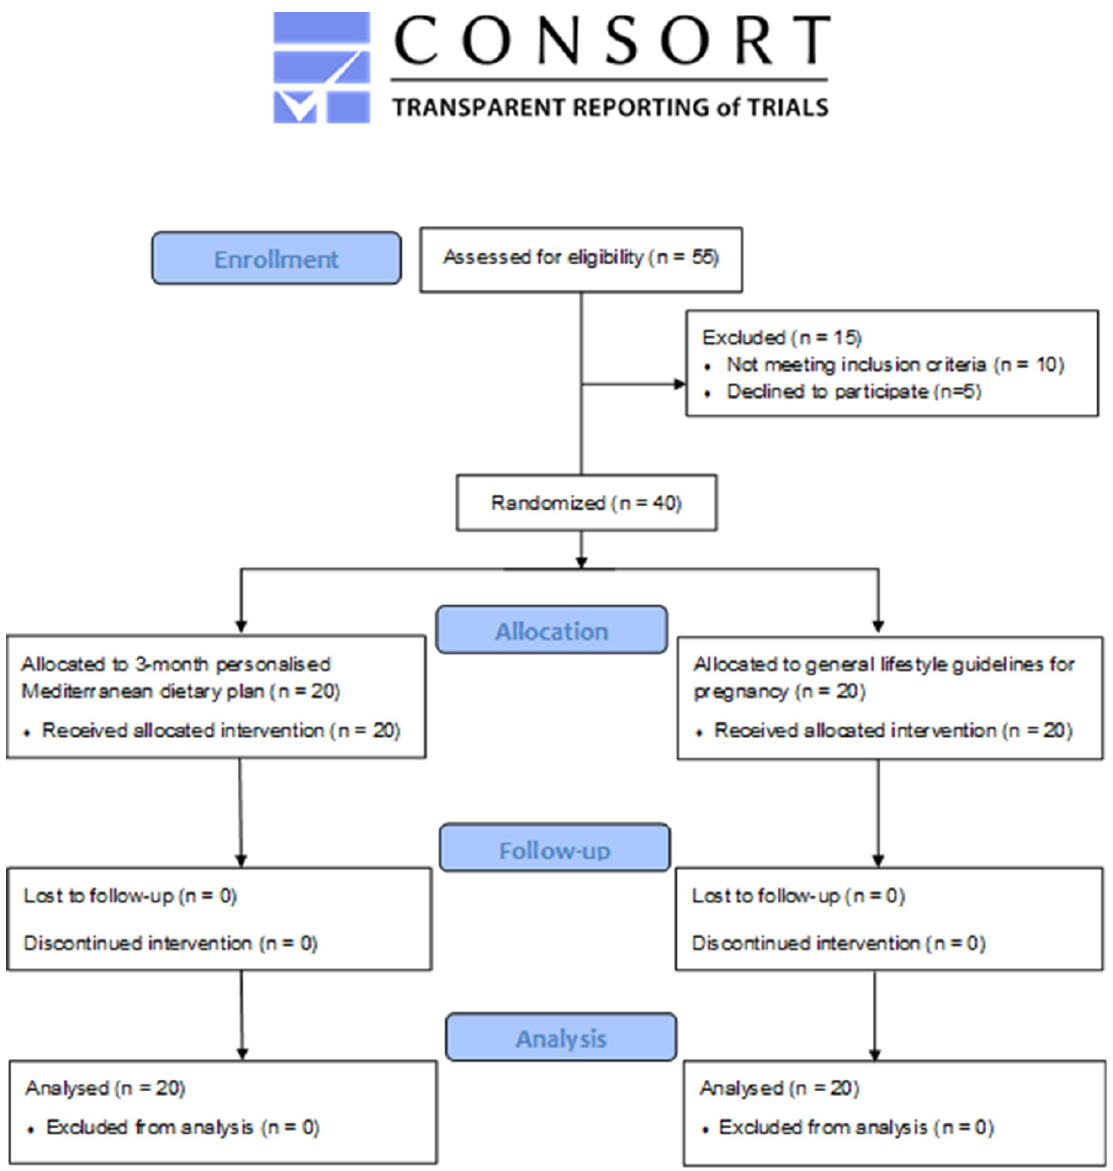
Figure 1. CONSORT flow diagram.